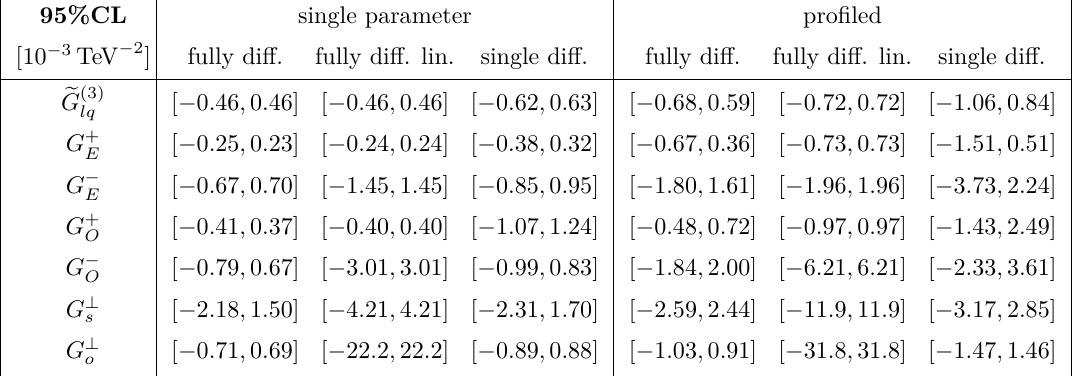
, G ± , G ± and G ⊥ , including a s,o E O lq